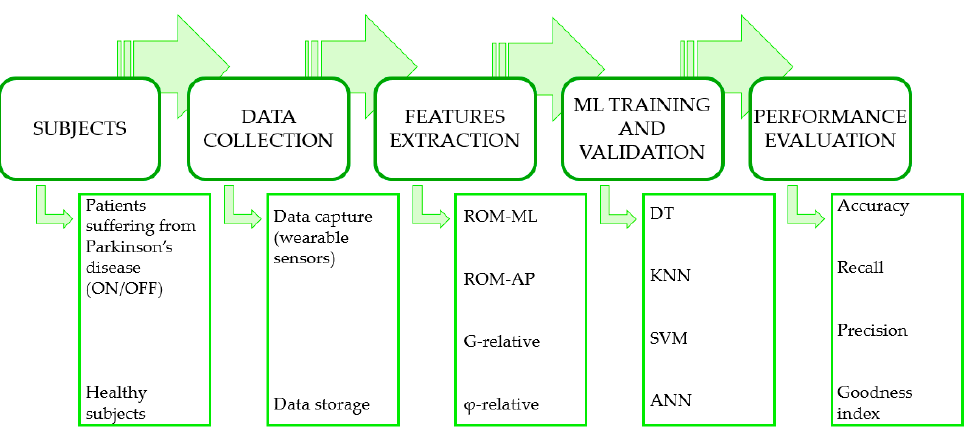
Figure 3. Complete process flow of the